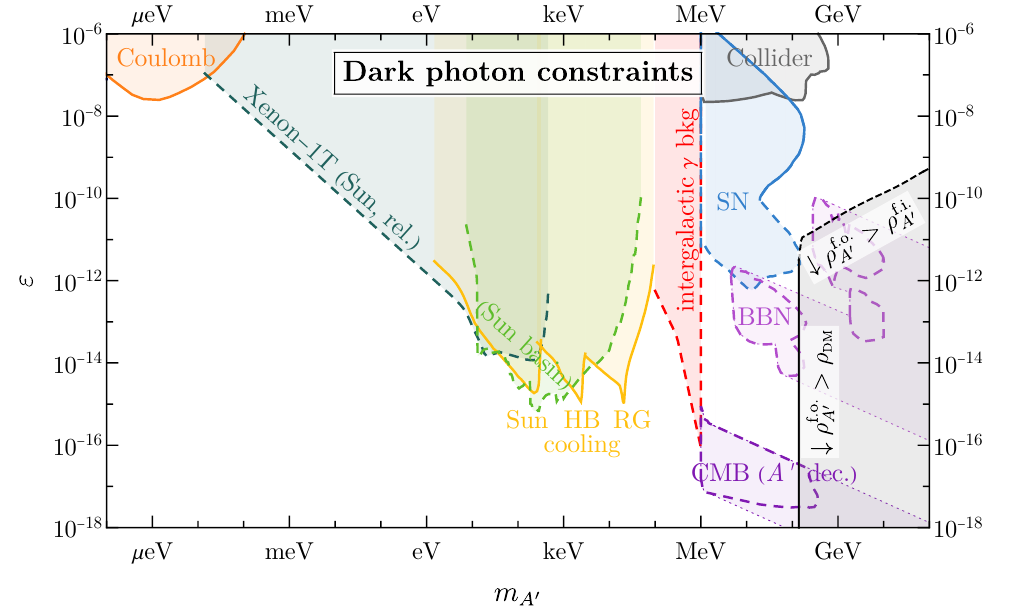
Figure 8. Summary plot of the constraints in the plane ( m A 0 , ε ) in the presence of a kinetic mixing. The colored bounds are experimental and cosmological constraints on dark photons (see the text for their description). The bounds shown with a dashed line would sensibly shrink or disappear in the case of heavy dark photon ( m A 0 > 2 m ψ ) if e d (cid:29) εe , because the dark photon would decay into ψψ shortly after production. The black lines identify the regions where the freeze-out relic density ρ f.o. would be overabundant with respect to dark matter (solid) or to the freeze-in abundance of A 0 A 0 (dashed). These lines assume H I = 6 × 10 13 GeV and η = 6